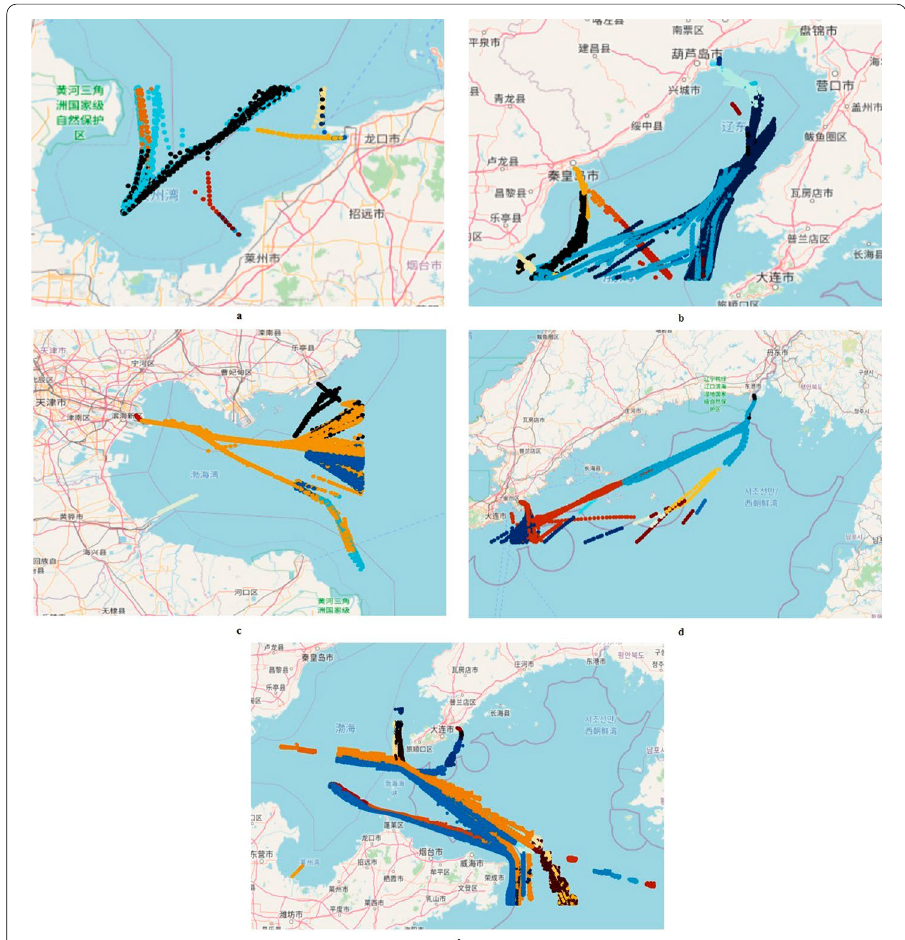
Fig. 4 The trajectories with directions for the five main areas in the Bohai Sea